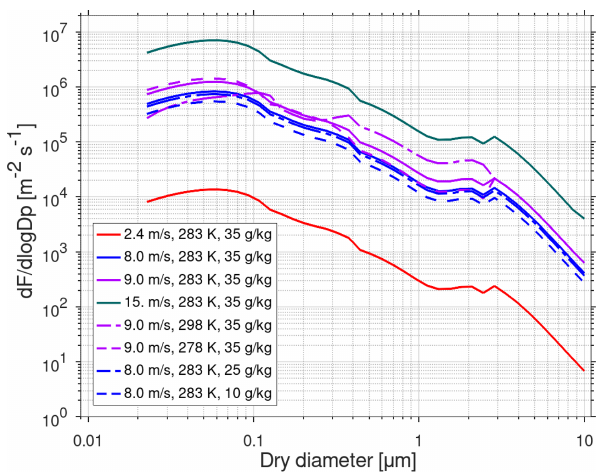
Figure 5. Sea salt particle source function (size-dependent num- ber flux, F ) at different wind speed, sea surface temperature, and salinity with the parameterization by Spada et al. (2013). The effect of wind speed is shown with the green, violet, blue, and red solid lines (at SST 283K and salinity of 35gkg − 1 ). The effect of SST is shown with the solid and dashed violet lines (at 9ms − 1 and salin- ity of 35gkg − 1 ). The effect of salinity is shown with the solid and dashed blue lines (at 8ms − 1 and SST